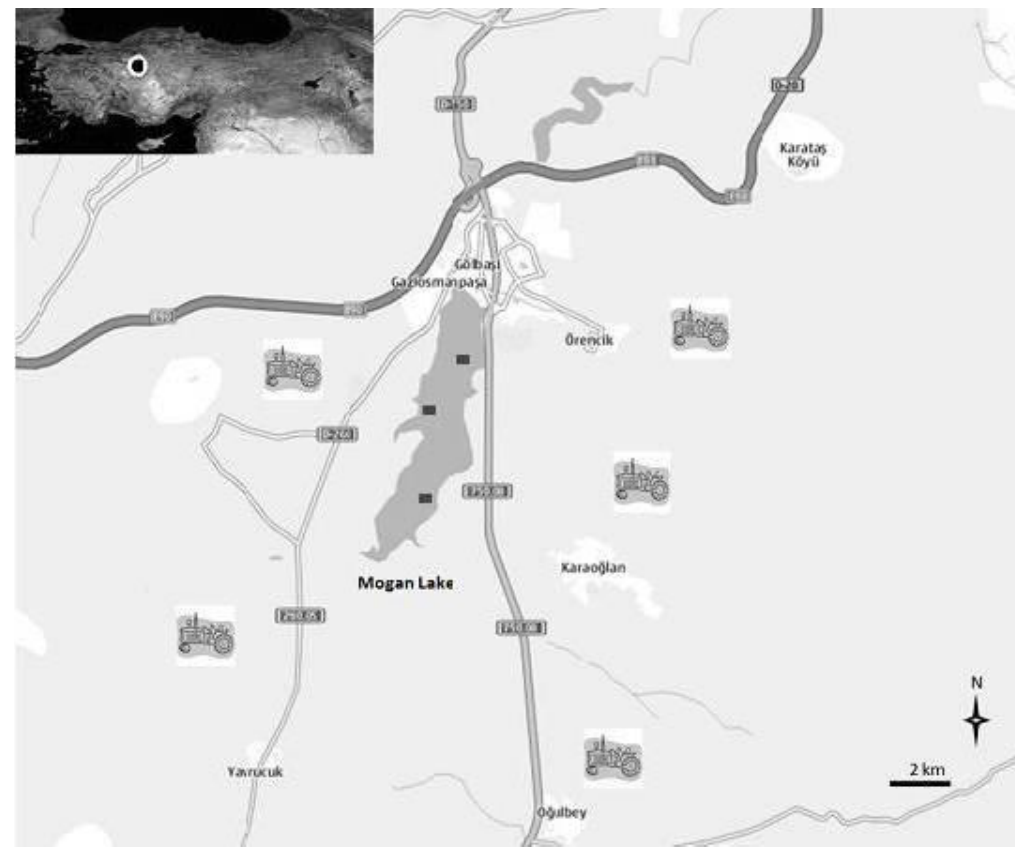
FIGURE 1. Map of Turkey showing the location of the study area, Lake Mogan. Squared areas show where sampling was